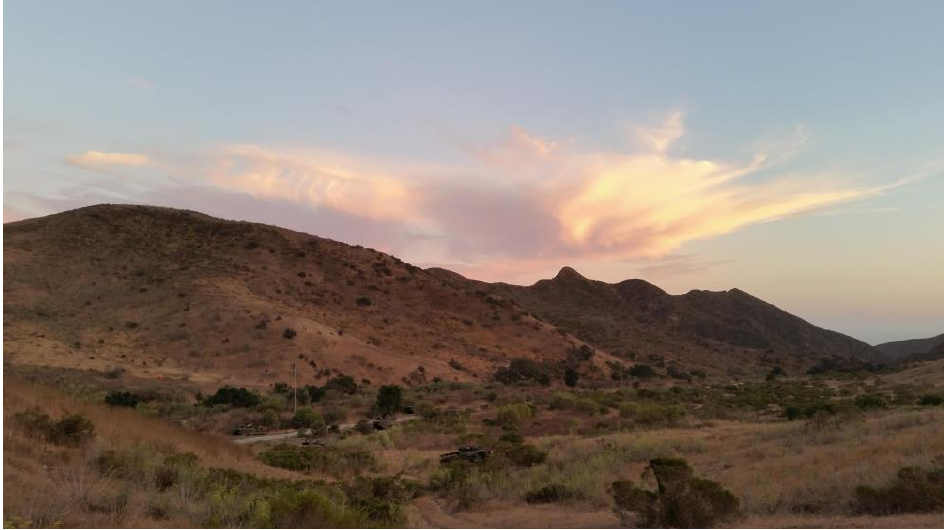
Figure 2 Jezabeth Roca Gonzalez, Gringolandia , 2018, Photograph.